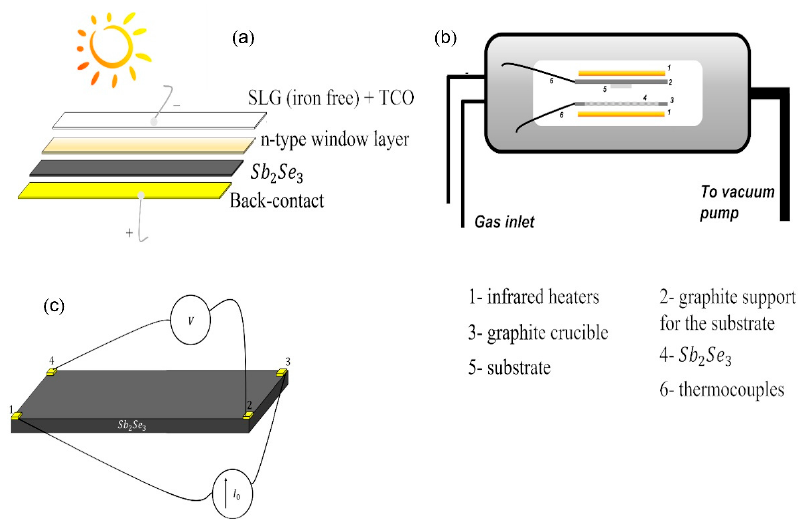
Figure 1. ( a ) The superstrate structure of the solar cells; ( b ) Sketch of CSS system; ( c ) van der Pauw measurement configuration.